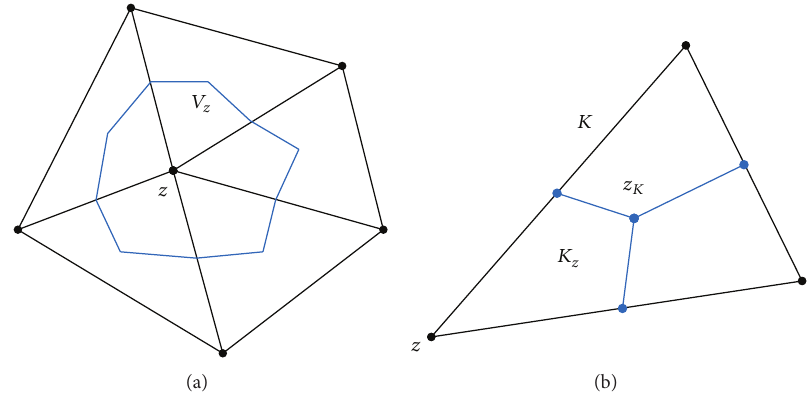
Figure 3: 𝑧 𝐾 is the barycenter of 𝐾 , and 𝑞 𝑒 is to be the midpoint of the edge 𝑒 .